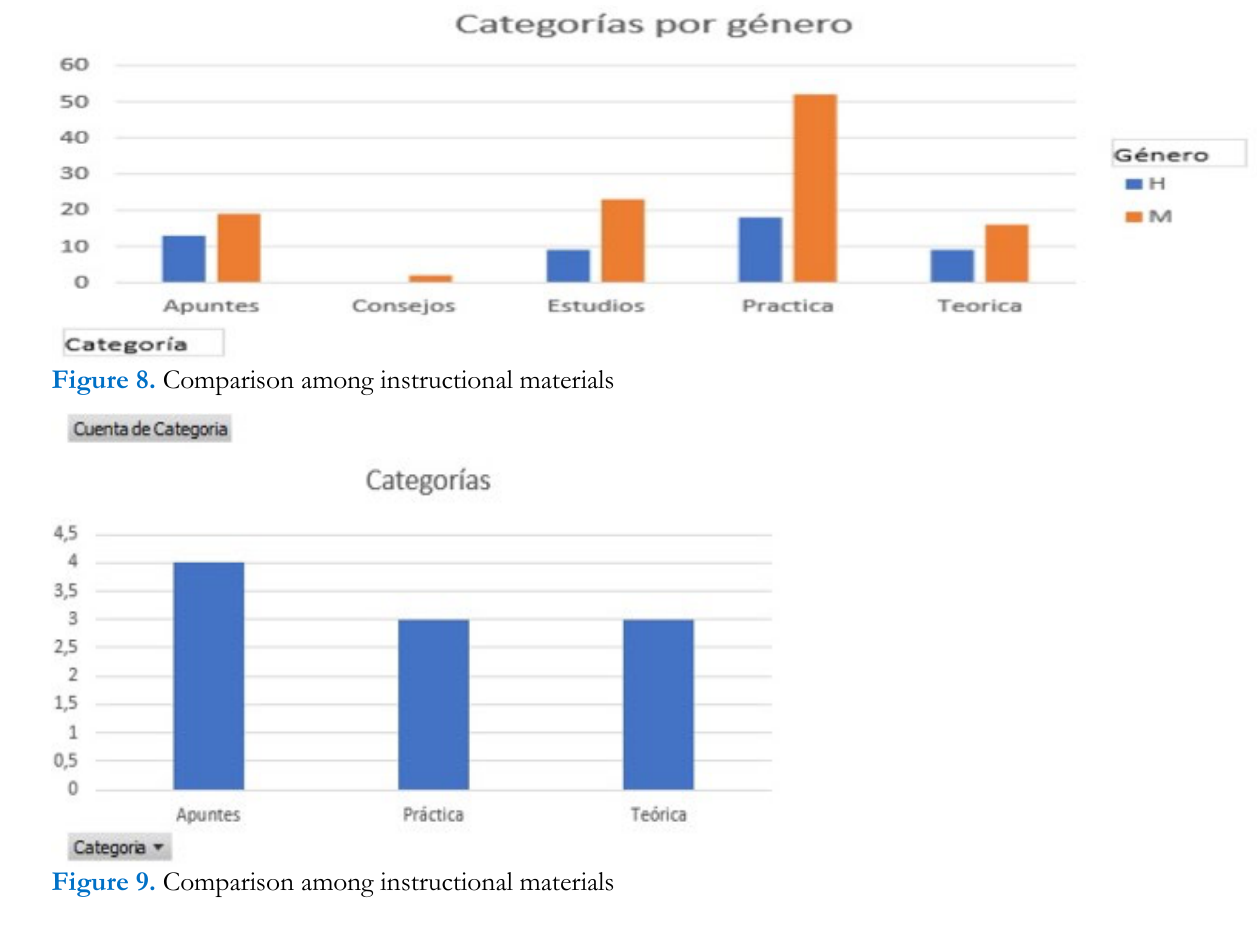
Figure 7. Comparison among instructional materials